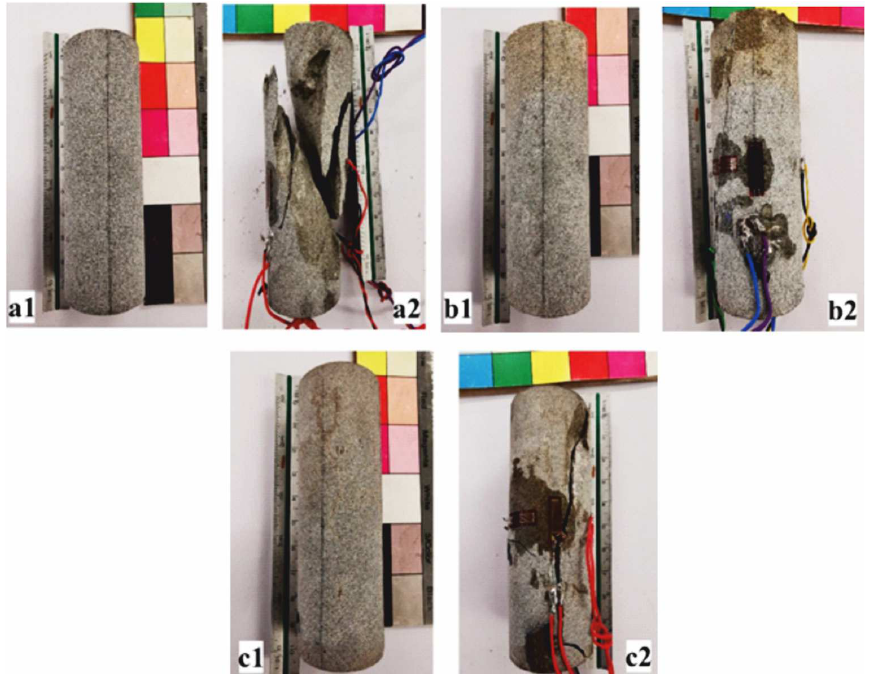
Figure 9. Typical breaks in cylindrical specimens under uniaxial compressive strength before and after the testing of the corresponding samples. ( a1 , a2 ) (sample OX-6C), ( b1 , b2 ) (sample OX-4B) are from Pentalofos Formation sandstones; ( c1 , c2 ) (sample KAL-3B) from Southern Eptachori Formation sandstones. Note the strain gauge sensors that were emplaced for the measurements in vertical and horizontal orientations.